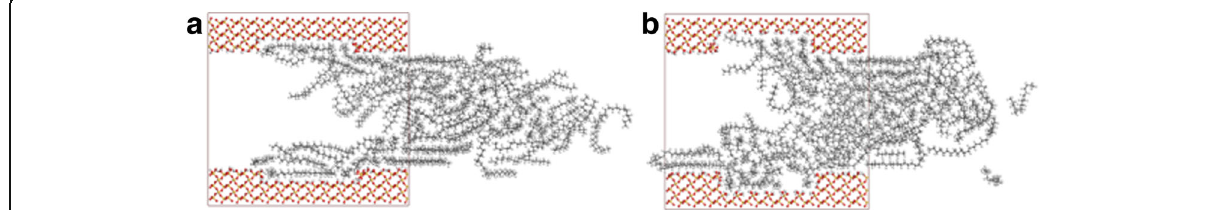
Fig. 11 Snapshots of octadecane transportation in rough channel with the cavity depth of a 3 and b 6 Å at 2